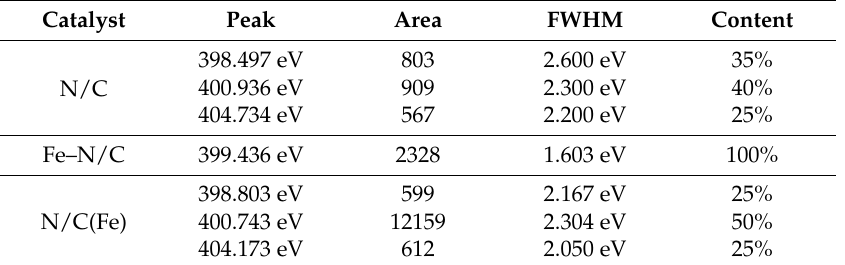
Figure 6. ( a ) XPS survey spectra of N/C, Fe–N/C and N/C (Fe). ( b ) XPS spectra of C1s of N/C, Fe–N/C and N/C (Fe). ( c ) XPS spectra of N1s of N/C, Fe–N/C and N/C (Fe). Table 1. Peak positions, areas, full widths at half maximum (FWHM) and concentrations of N1s species in N/C, Fe–N/C and N/C (Fe) obtained from the XPS results. Catalyst